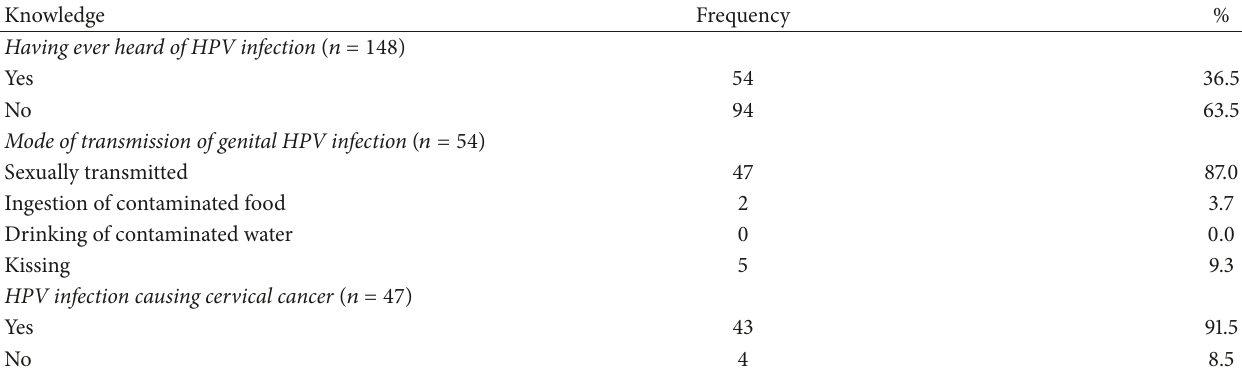
Table 2: Knowledge of HPV Infection.